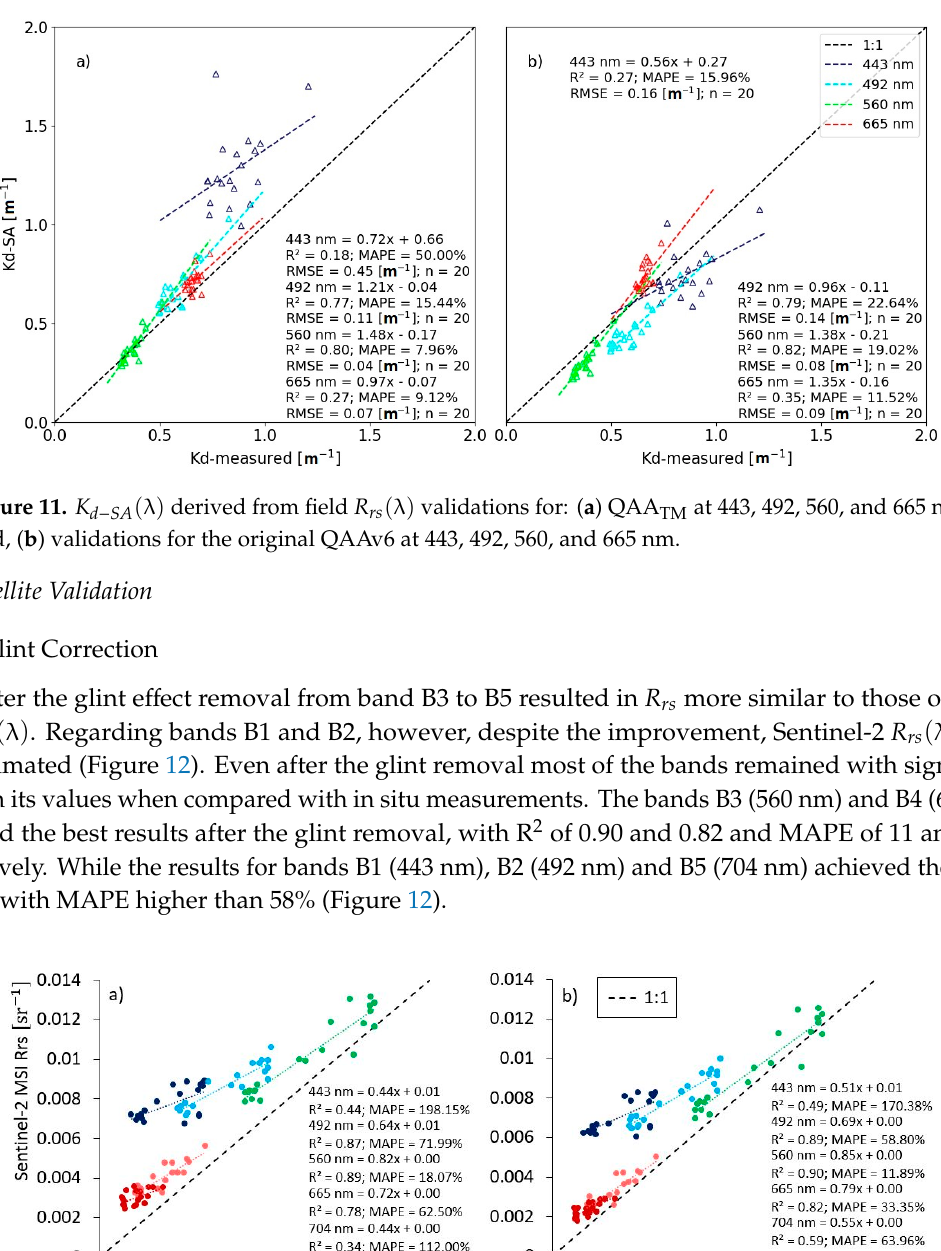
Figure 12. Comparison between Field 𝑅 (cid:3045)(cid:3046) (λ) and MSI 𝑅 (cid:3045)(cid:3046) (λ) for B1 to B5: ( a ) without glint removal;